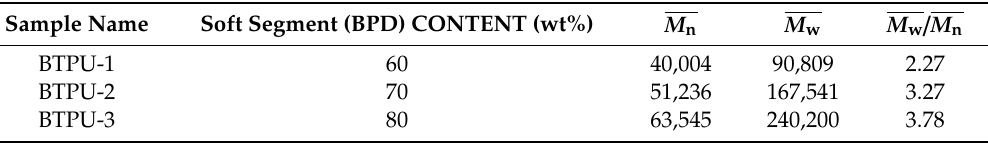
Table 2. Molecular weight and molecular weight distribution of BTPU.